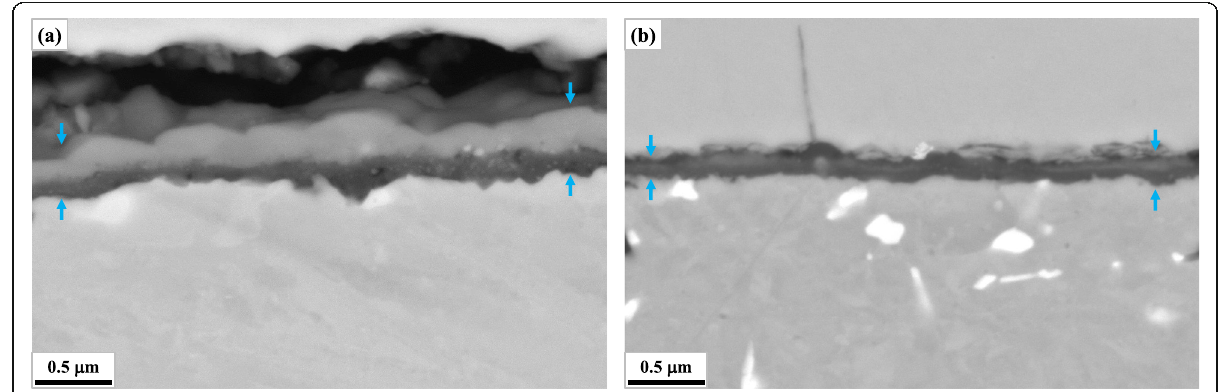
Fig. 5 Microstructures around the scales after 336 h of oxidation (SEM-BEI): a W0, b